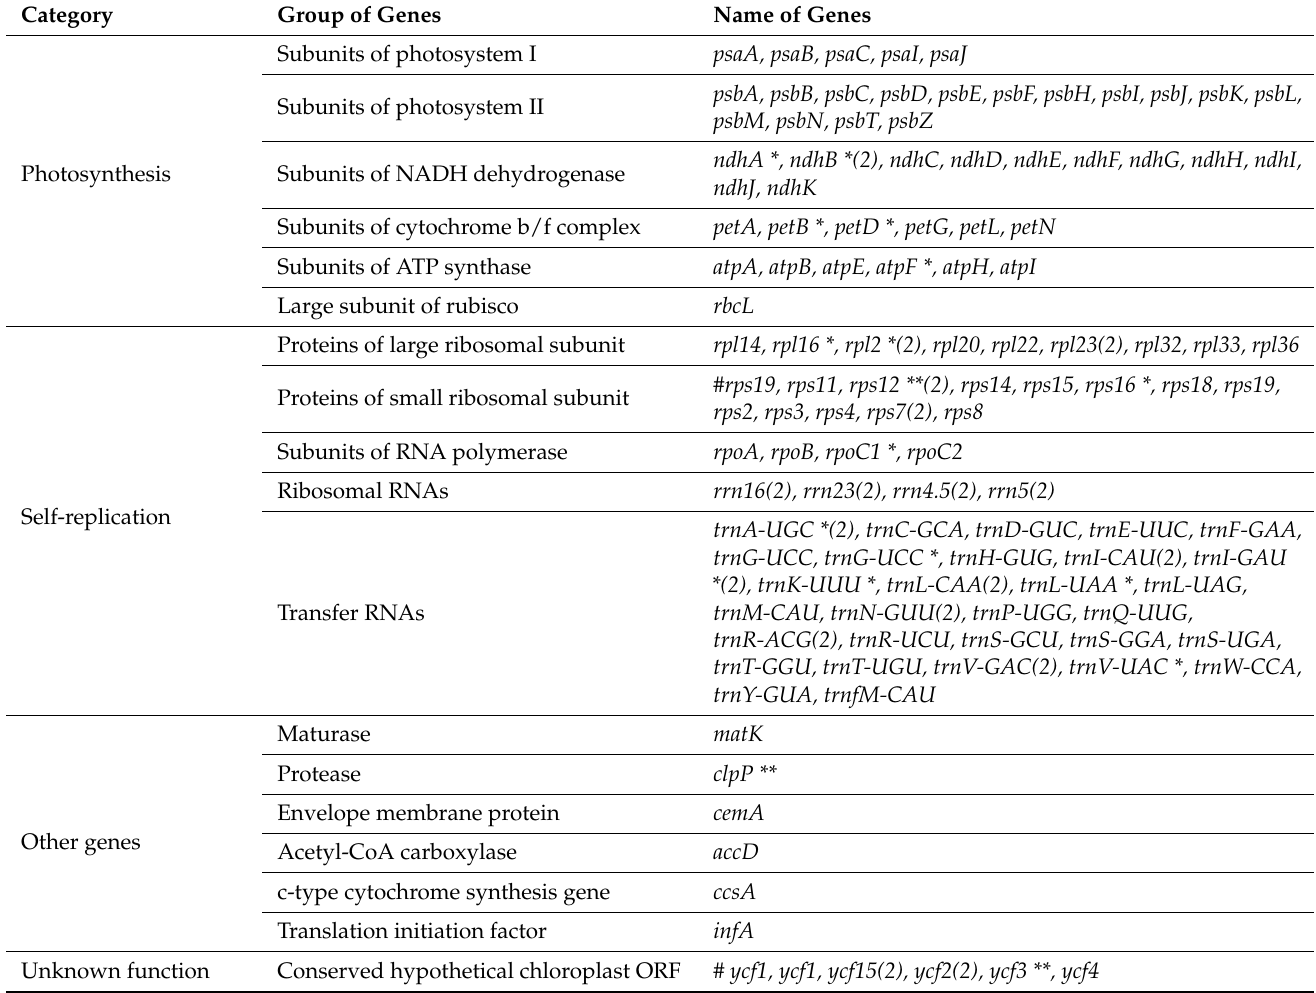
Table 3. List of annotated genes in the sequenced Camellia chloroplast genomes.